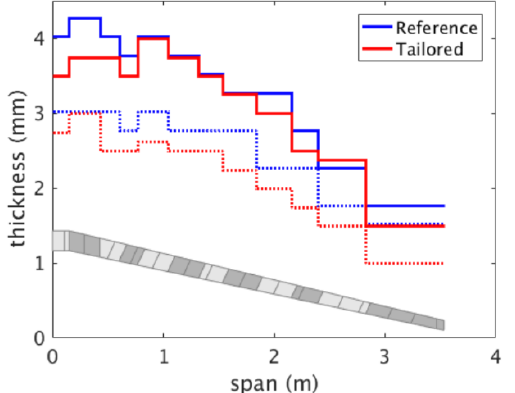
Figure 6. Thickness distribution in the reference and tailored wing along the span in the upper skin (continuous line) and lower skin (dotted line).